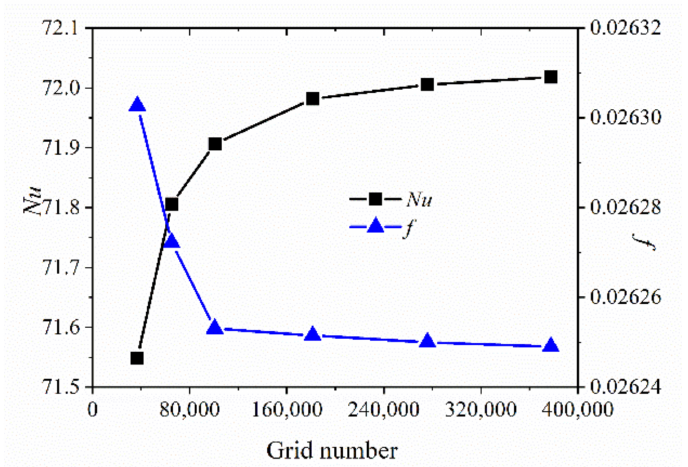
Figure 6. Grid independence